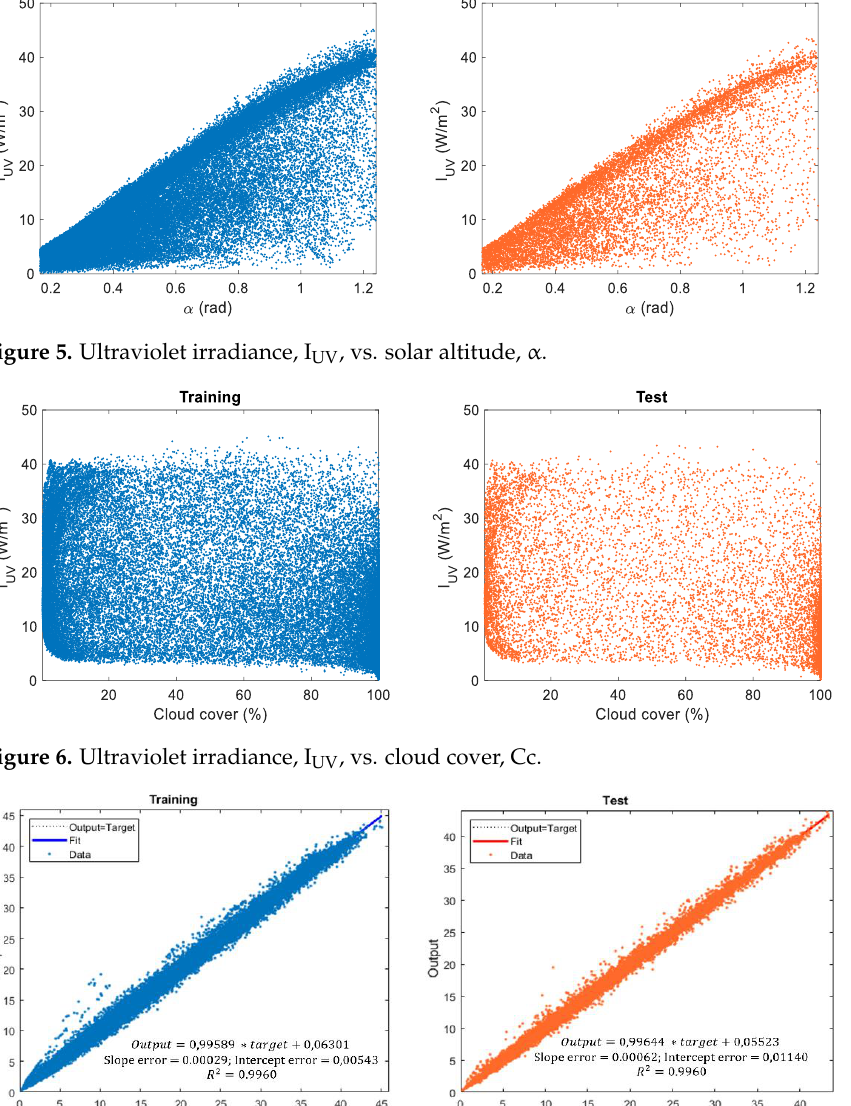
= f ( I α , Cc ) , using ANN model UV GH ,